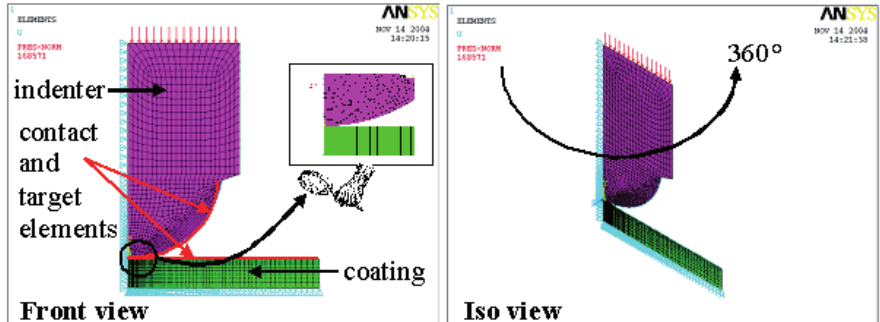
Fig. 5. Axisymmetrical finite element model.